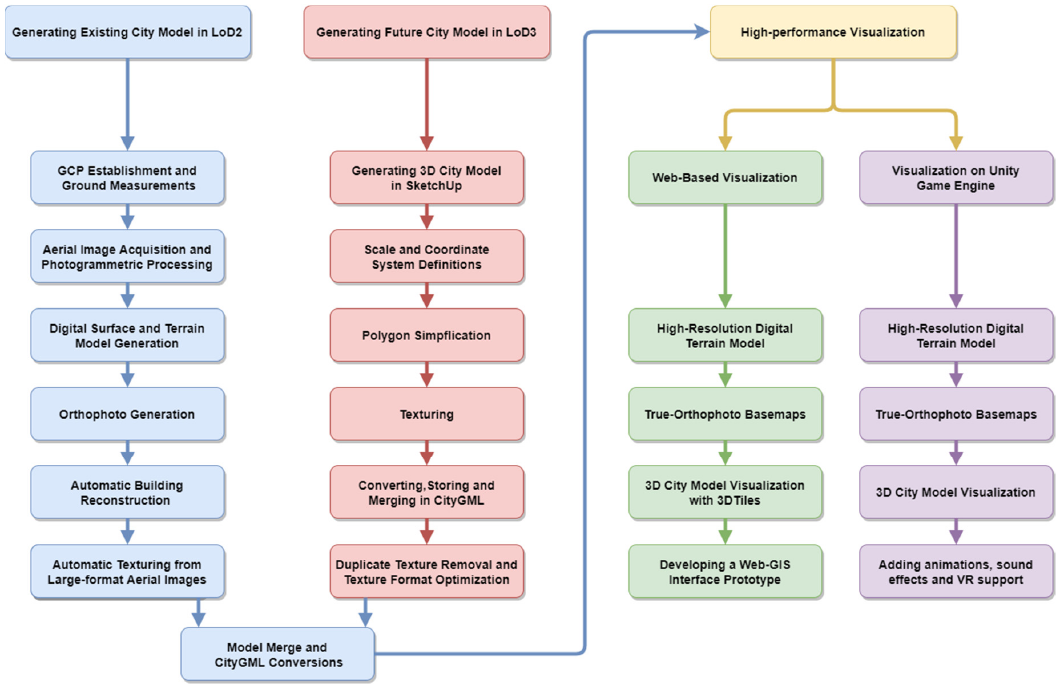
Figure 2. The overall workflow of the data production, model implementation, and visualization.